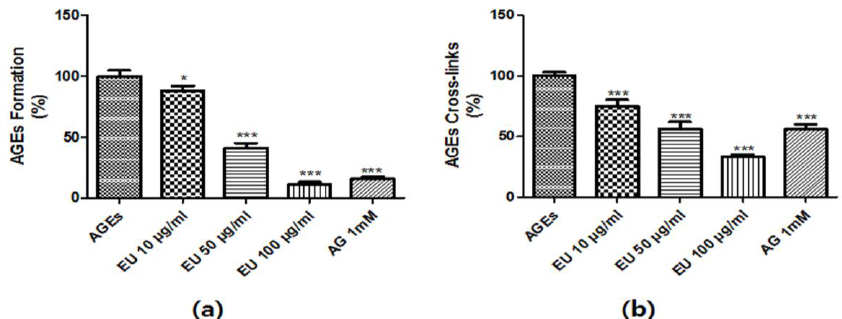
Figure 2. The inhibitory effect of Eucommia ulmoides Oliv. (EU) on advanced glycation end-products (AGEs) formation and AGEs-induced cross-link to collagen. ( a ) The effects of EU on in vitro AGEs formation was examined using an AGEs formation assay. Bovine serum albumin (BSA, 5 mg/mL) was incubated with 25 mM of glucose and fructose in the presence or absence of EU in phosphate-buffered saline (PBS) for 14 days; ( b ) AGEs cross-linking inhibition by EU was evaluated by determining the optical density of AGEs-collagen cross-linking using tetramethylbenzidine (TMB) as the substrate. The results of each experiment are presented as the mean ± SD (%) of three independent experiments for three repeat experiment on each sample (* p < 0.05 and *** p < 0.001 vs.